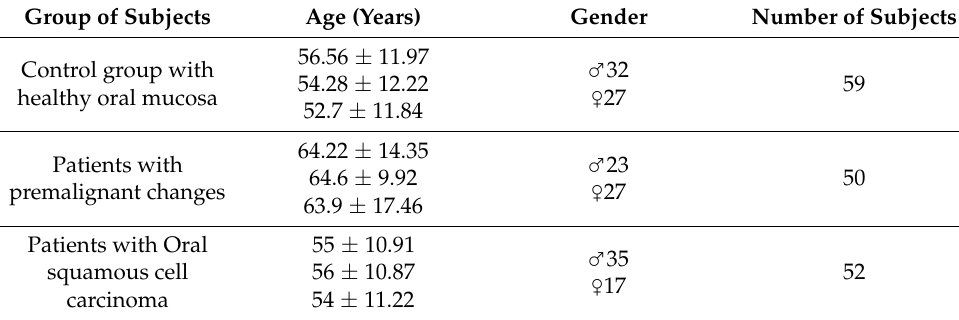
Table 1. Demographic data of subjects included in the study. Group of Subjects Age (Years) Gender Number of Subjects Control group with healthy oral mucosa Patients with premalignant